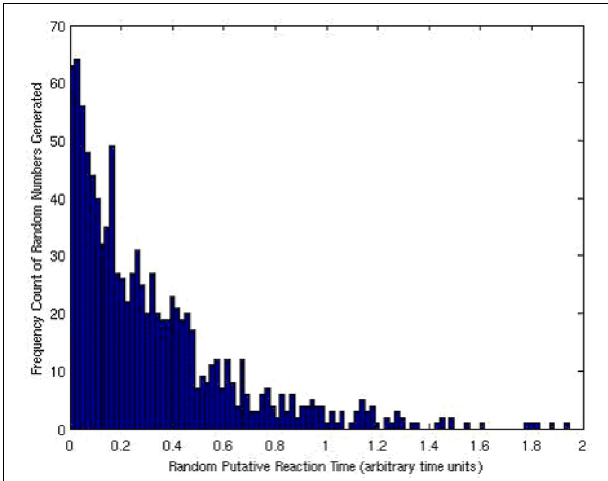
FIGURE 12 | The histogram (and thus a scaled probability distribution function) of the exponentially distributed Gillespie reaction times, τ i ’s,